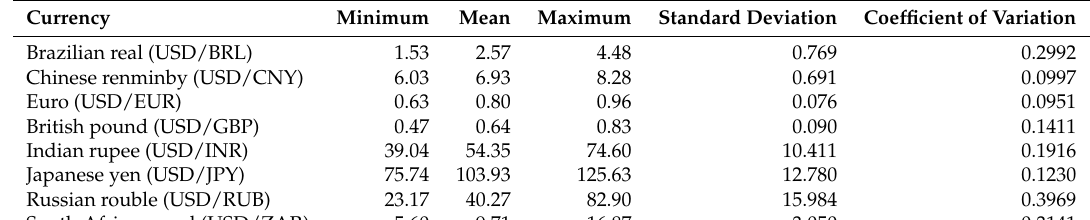
Table 1. Descriptive measures for the eight currency exchange rates.